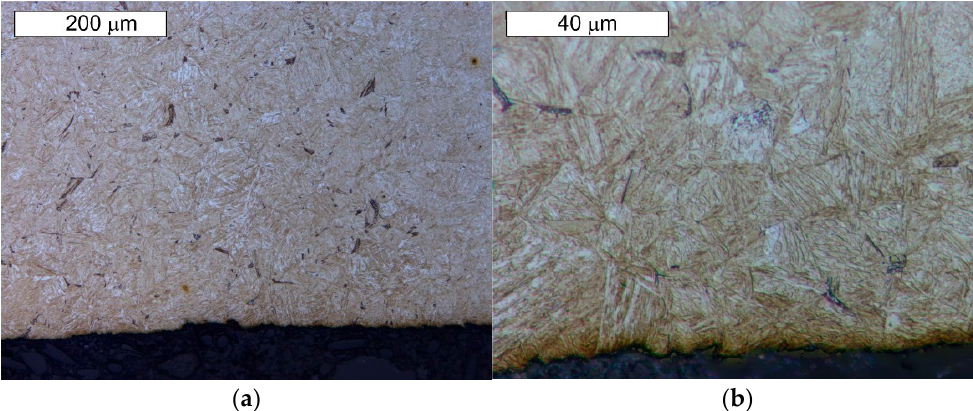
Figure 9. Material microstructure in the wear area on the cross-section of sample 1: ( a ) visible basically uniform surface fatigue; ( b ) magnified fragment of the area from Figure 9a. Light microscopy, etched state.